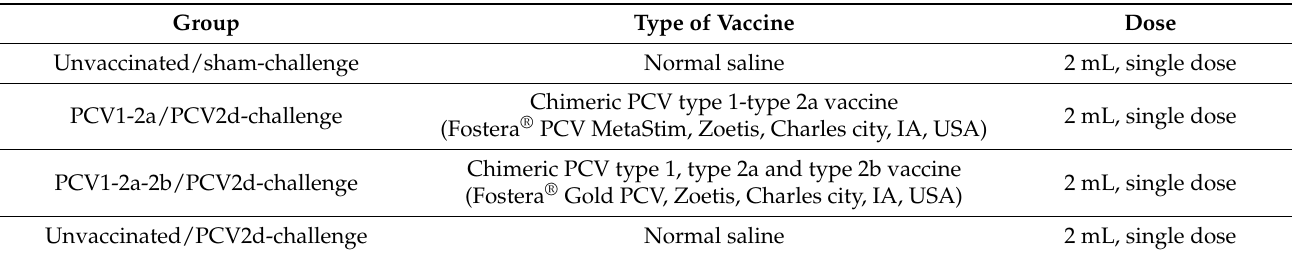
Table 1. Experimental design and vaccination plan in this